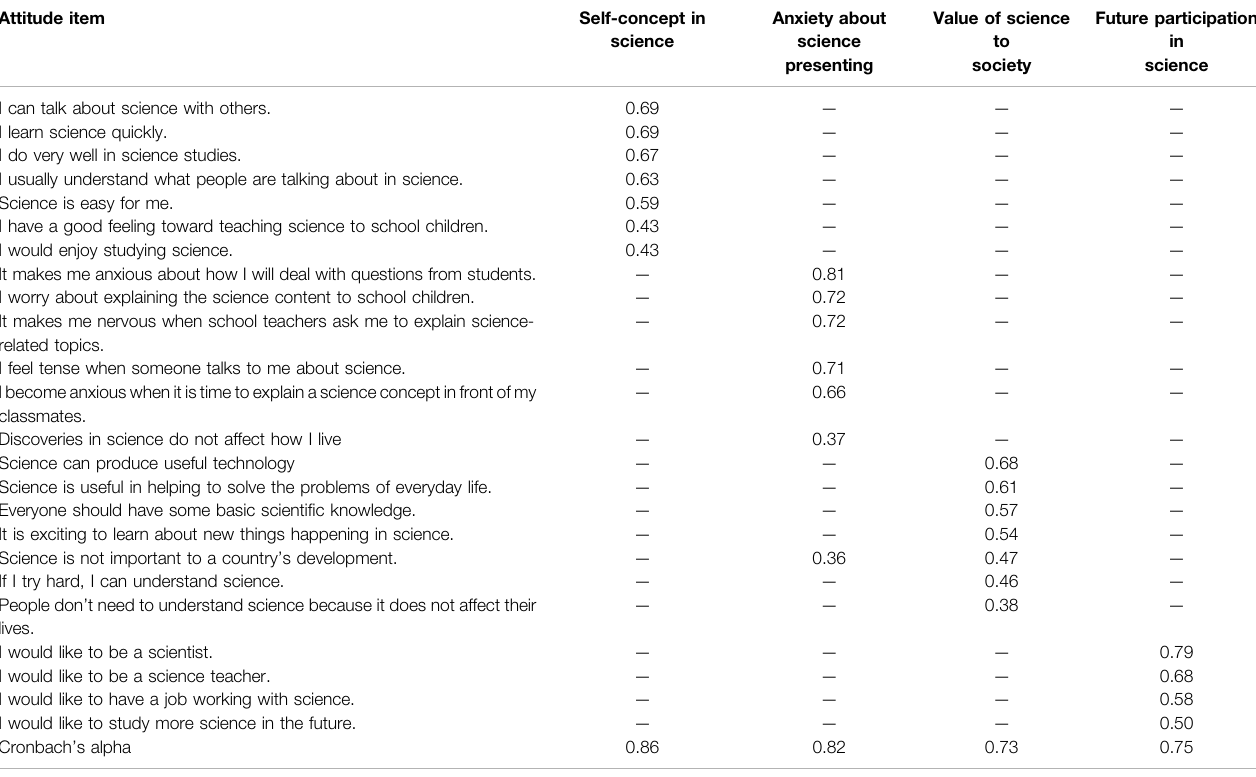
TABLE 1 | Summary of rotated factor analysis loading results > 0.35 for 24 items on attitude towards science in the post-presenting survey.